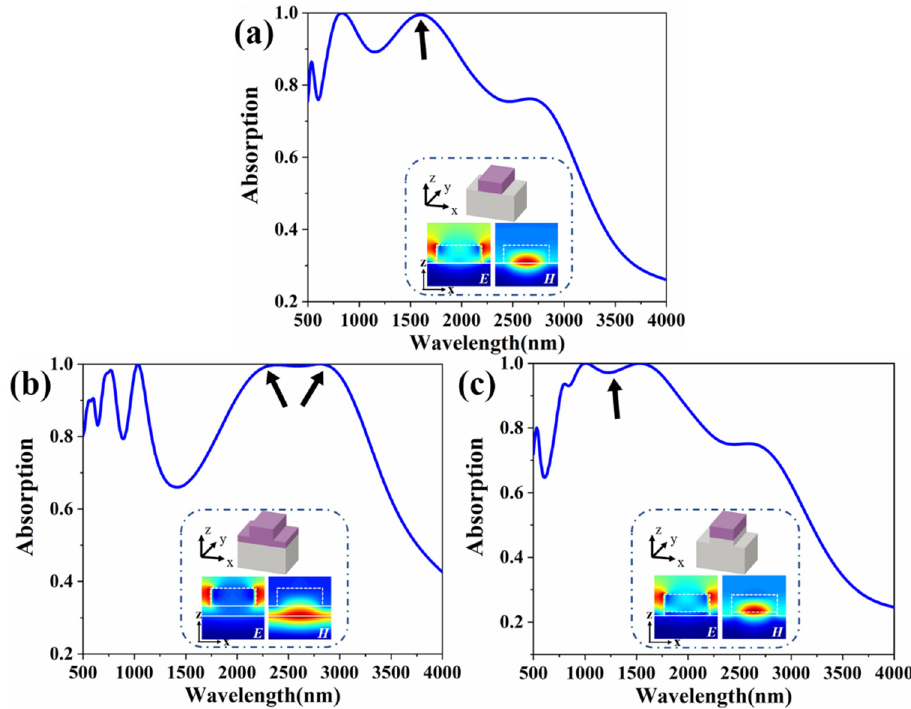
Figure 5. Changes in the light absorption capacity of the structure after removing h2, ( a ) h3; ( b ) h2; and ( c ) h3.